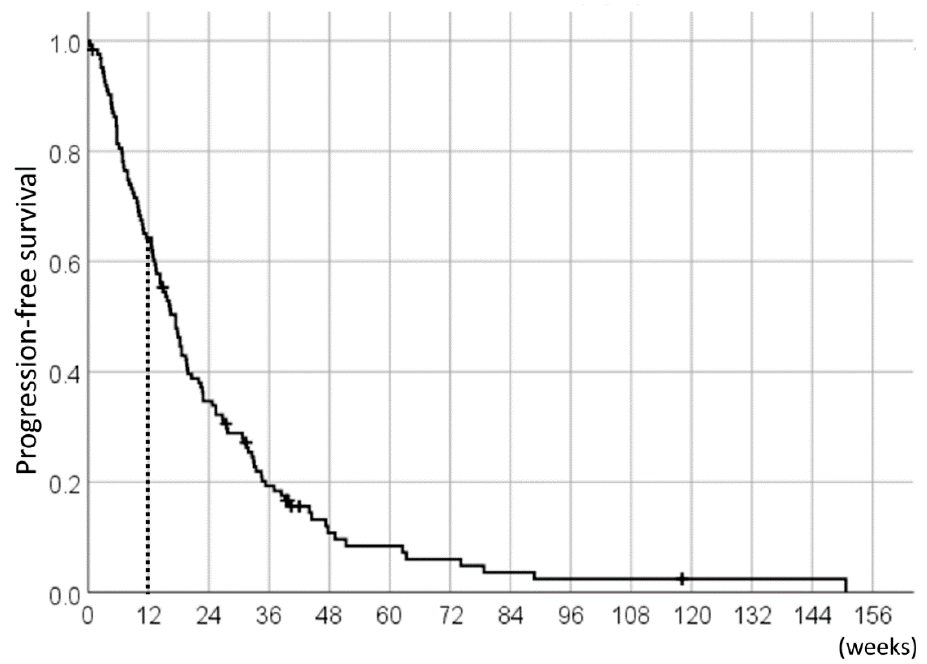
Figure 1. Progression-free survival (PFS) of the 124 pazopanib-treated soft tissue sarcoma (STS) patients.